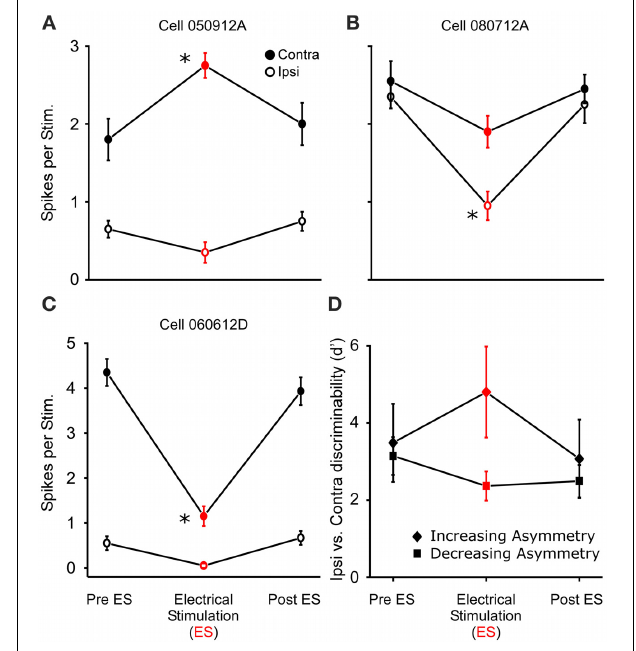
FIGURE 8 | Thalamic stimulation causes different relative modulation of binaural sensitivity to ipsilateral and contralateral (re. electrical stimulation site) sounds. (A–C) Sensitivity to ipsi and contralateral acoustic stimulation before during and after electrical stimulation in three separate cells. Each cell shows greater excitation to the contralateral sound. (A,B) Electrical stimulation causes an increase in relative binaural sensitivity. (C) Decrease in relative binaural sensitivity. (D) Summary of 11 and 7 cells showing increased (diamond) and decreased (square) relative sensitivity, respectively (plotted as d (cid:5) ). Asterisks note statistically significant modulation. Examples of ear specific modulation in voltage and histogram records are shown in Supplementary Materials 1 and 2,